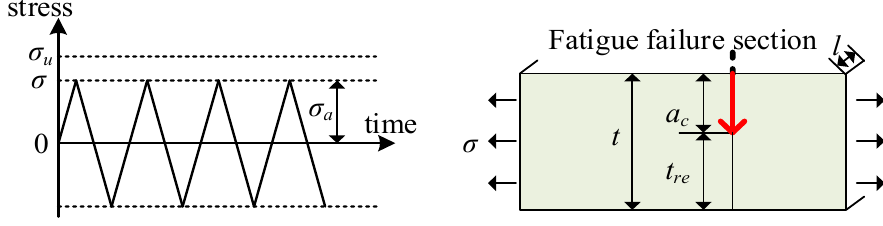
Figure 1. Fatigue failure process of homogeneous materials.